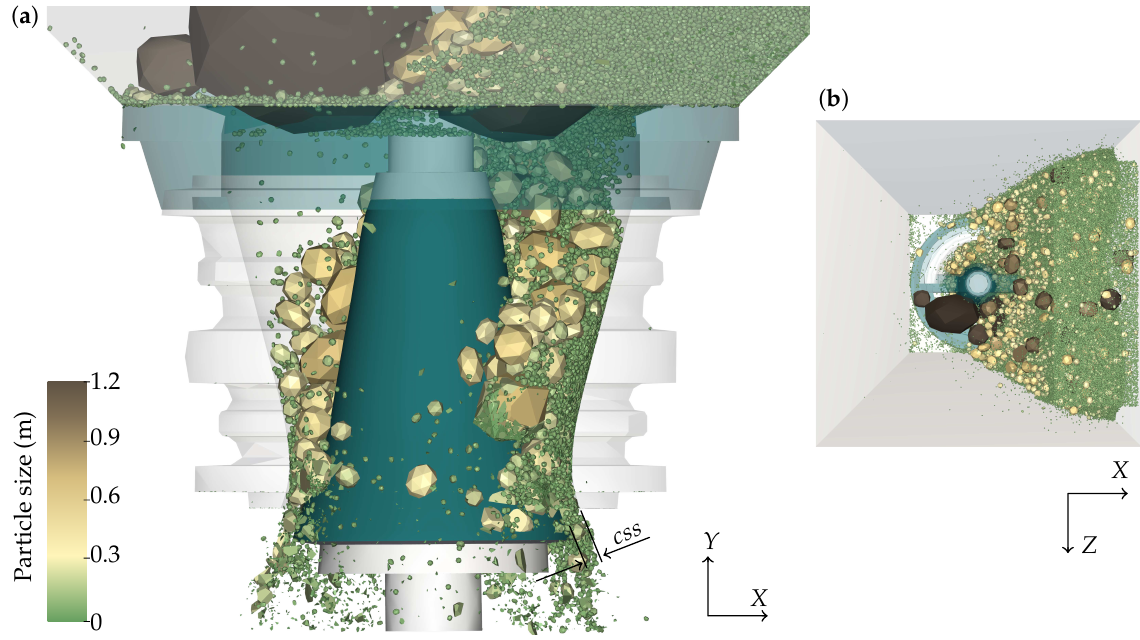
Figure 13. Snapshot of the non-uniform feeding simulation at t = 12.2 s showing a frontal section of the crusher. The particles are colored by their particle size, and the concave was cut in order to observe the particles. The position of the closed side setting, css , is also presented: ( a )frontal view and ( b )top